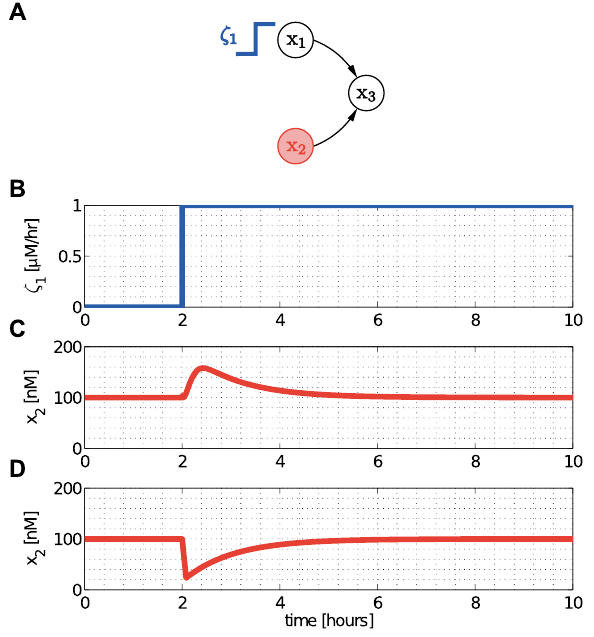
Figure 5. Nodes can become coupled via common downstream targets. (A) Node x 3 has two parents: x 1 and x 2 , without a regulatory path between them. (B) Perturbation f 1 applied to x 1 . (C) In the case of competitive binding, increasing the concentration of free x 1 yields more of x 1 bound to the promoter of x 3 , forcing some of the molecules of x 2 to unbind, thus increasing the free concentration x 2 . Consequently, x 1 acts as if it were an activator of x 2 . (D) By contrast, in the case of cooperative binding, when the binding of x 1 must precede that of x 2 , pulses in x 1 yield pulses of the opposite sign in x 2 . Consequently, x 1 acts as if it were a repressor of x 2 . Simulation parameters